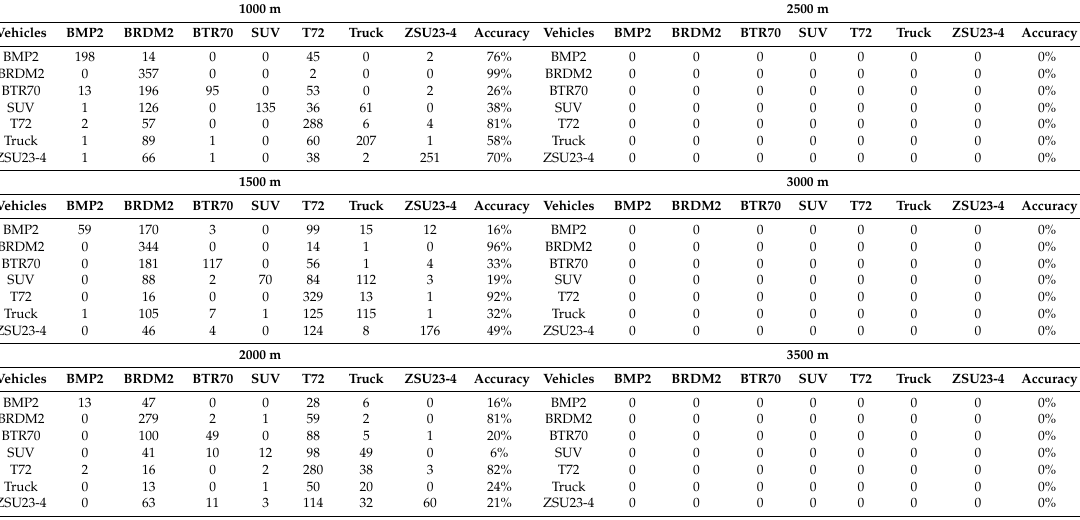
Table A12. Classification results for PCE 25 case (MWIR nighttime). Left shows the confusion matrix and the last column shows the classification